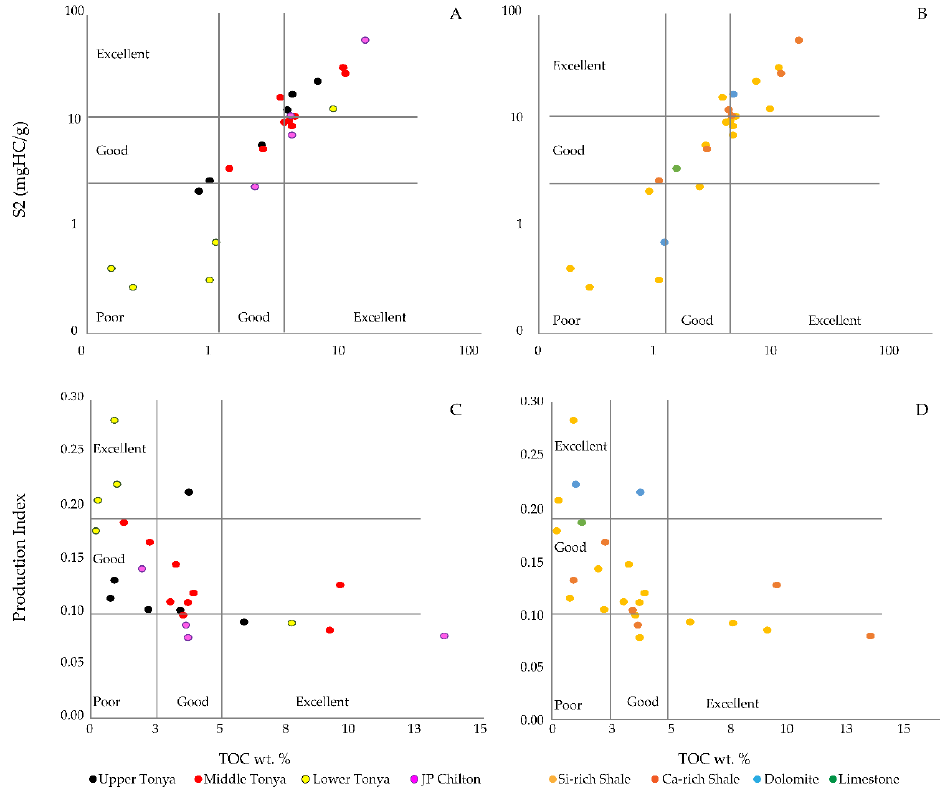
Figure 10. Source rock evaluation indices sorted by depth and lithofacies modified from Peters and Cassa (1994) [117] and Peters (1998) [90]. ( A , B ) Display of S2 yields increasing with TOC wt. % and indicate good potential for Permian and Pennsylvanian age sediments regardless of lithofacies. ( C , D ) Production index versus TOC wt% plots show that samples have generally good potential for oil generation (0.10–0.30) with moderate to good potential for sizeable expulsion (TOC > 3%) despite of lithofacies and depth. Geosciences 2020 , 10 , x FOR PEER REVIEW